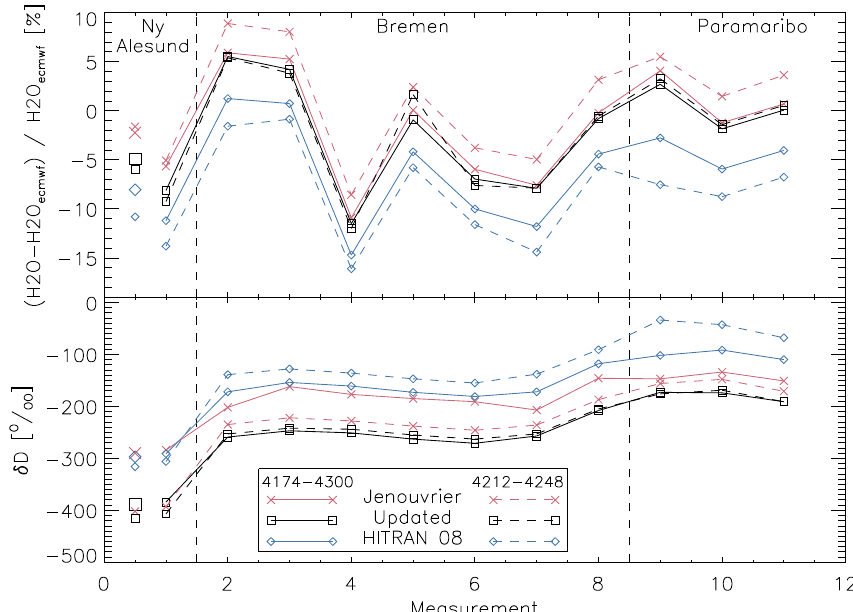
Fig. 6. The impact of the different line lists and retrieval windows on the H 2 O column and δ D from different ground-based FTS spectra. Solid and dashed lines are for the 4174–4300cm − 1 and 4212–4248cm − 1 window, respectively. Measurements for the different stations are separated by the vertical dashed lines (stations indicated at the top). Top: relative difference with the total column H 2 O derived from ECMWF. For the Ny ˚Alesund retrieval we also compare with the total column derived from a radiosonde, indicated by the separated symbols on the left (large symbols for 4174–4300cm − 1 and small symbols for 4212–4248cm − 1 ). Bottom: retrieved δ D.